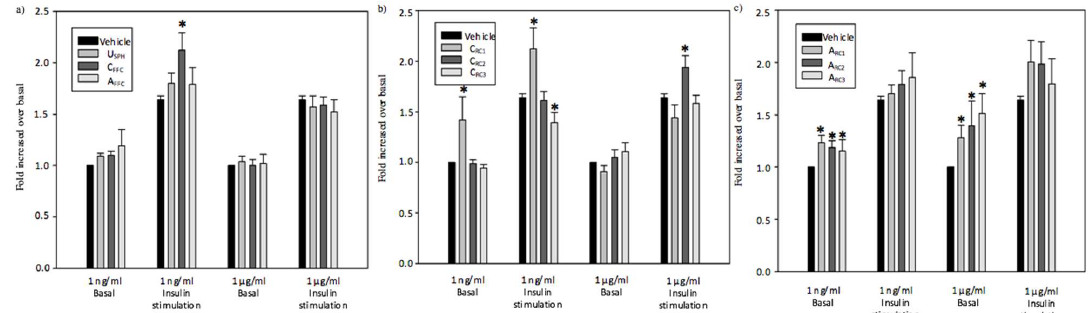
Figure 3. Glucose uptake modulation in L6 skeletal muscle cells in absence or presence of insulin stimulation by ( a ) U SPH , C FFC , and A FFC , ( b ) cationic compartments (C RC1 , C RC2 , and C RC3 ) and ( c ) anionic compartments (A RC1 , A RC2 , and A RC3 ) generated after 6 h of the EDUF process. One asterisk indicate that mean values are significantly di ff erent ( p < 0.05) than the mean value for the